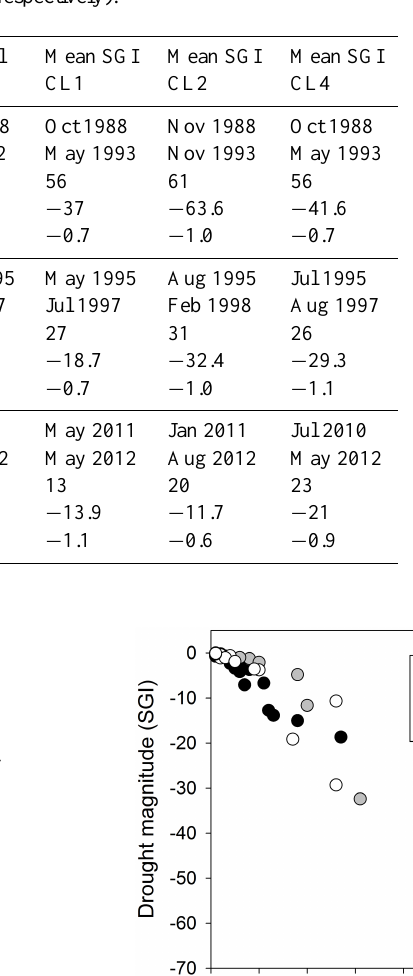
Table 3. Summary of the 1988–93, 1995–98 and 2011–12 drought events for clusters CL1, CL2 and CL4 (where D event , M event and I event denote indices for drought event duration, magnitude and intensity respectively).